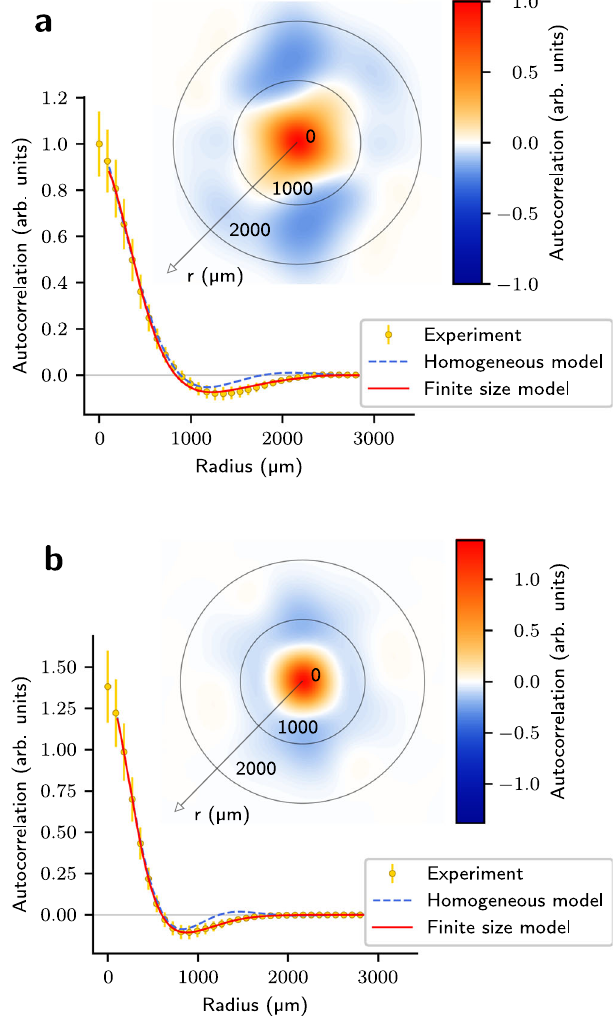
Fig. 3 Comparison between experiment and photon bubble model. Auto- correlation structure at the transition region, δ = − 2 Γ ( a ), and in the turbulent regime, δ = − 0.75 Γ ( b ). The blue dashed curve depicts the fi t to the spherically symmetric solutions of the homogeneous photon bubble model. The red curve shows the improved fi t when fi nite-size effects are taken into consideration. Both fi ts were performed only at scales larger than the probed layer thickness, where line-of-sight integration effects become negligible. Error bars have been de fi ned in Fig.